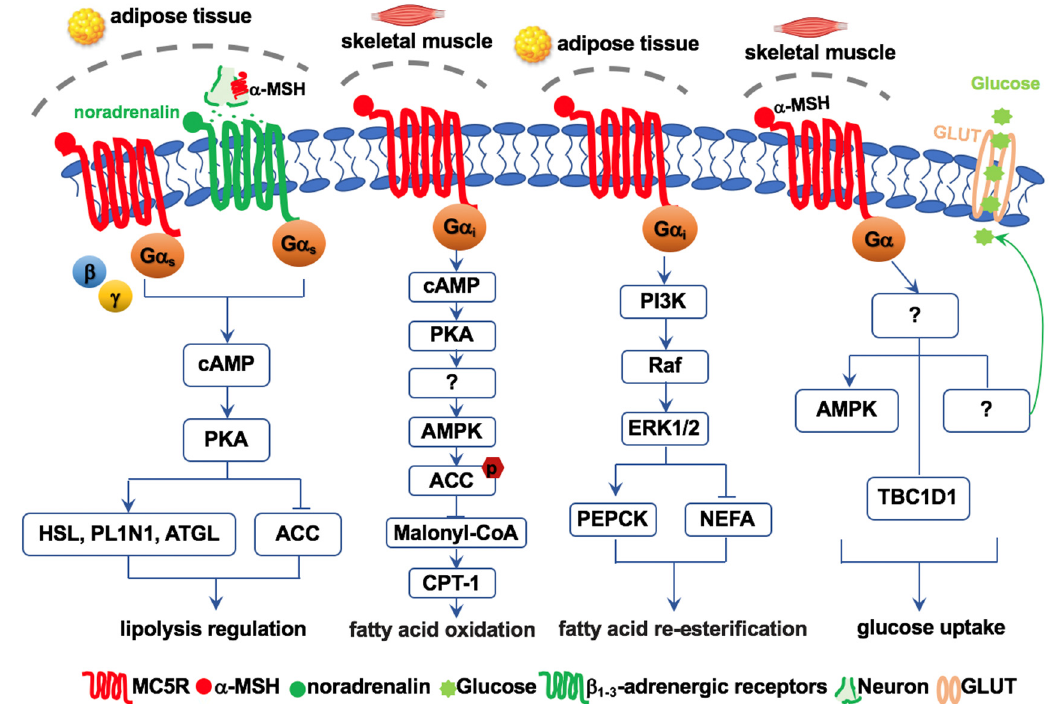
Figure 6. Schematic diagram of MC5R signaling pathways in lipid and glucose metabolism.